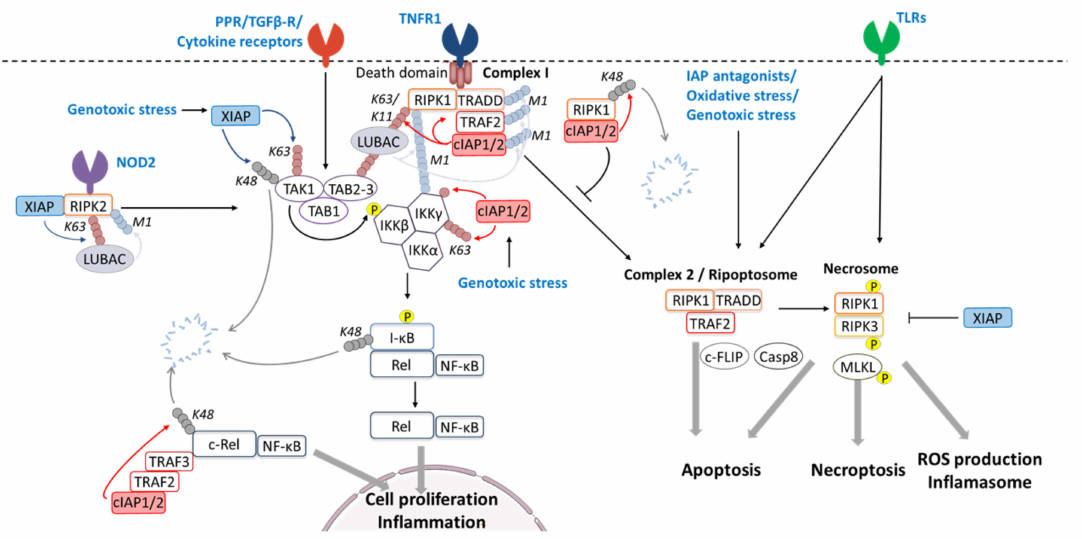
Figure 2. Regulation of the TNFR and canonical NF- κ B signaling pathways by IAPs. The activation of the tumor necrosis factor receptor 1 (TNFR1) induces the formation of the complex 1 composed of TNFR-associated death domain (TRADD), receptor-interacting kinase 1 (RIPK1), TNFR-associated factor 2 (TRAF2), and cellular inhibitors of apoptosis (cIAP1 / 2). The latter promote the ubiquitination of RIPK1 (K63 and K11-linked), leading to the recruitment of the linear ubiquitin chain assembly complex (LUBAC). In turn, LUBAC induces the conjugation of linear M1-linked polyubiquitin chains to complex 1 components. The resulting ubiquitin sca ff old allows the recruitment of TAK1 (tumor growth factor- β -activated kinase 1) / TAB1 / TAB2 / 3 (transforming growth factor-activated kinase1-binding protein 1, 2, and 3) complex and IKK (Inhibitor of κ B kinase) complex composed of IKK α / IKK β / IKK γ . TAK1 catalyses the phosphorylation of IKK β and the activation of IKK. This leads to the phosphorylation of the Inhibitor of κ B (I- κ B), its K48-linked ubiquitination, and proteasomal degradation, resulting in the release and nuclear translocation of NF- κ B subunits. Stimulation of PRRs (pattern-recognition receptors), TGF β -R (Transforming Growth Factor-beta receptor), cytokine receptors, NOD2 (nucleotide-binding oligomerization domain), or genotoxic stress can engage the canonical NF- κ B pathways by stimulating TAK1 / TAB1 / TAB 2 / 3 complex. XIAP (X-linked inhibitor of apoptosis protein) can positively regulate TAK1 activation through K63-linked ubiquitination or negatively through K48-linked ubiquitination and proteasomal degradation. In the case of NOD2 stimulation, XIAP promotes the K63-linked ubiquitination of RIPK2 that results in the recruitment of LUBAC and TAK1 activation. cIAPs can control IKK γ by promoting mono- or K63-linked ubiquitination, while the cIAPs / TRAFs E3-ubiquitin ligase complex can regulate c-Rel stability. A complex 2 derived from TNFR1-associated complex 1 or Ripoptosome that contain RIPK1 and RIPK3 can be formed in response to depletion of cIAPs by IAP antagonists, oxidative or genotoxic stresses, or TLRs (toll-like receptors) stimulation. Theses complexes can lead to apoptosis, necroptosis, or ROS production and inflammasome activation, depending on presence of the regulatory or e ff ector proteins c-FLIP (cellular FLICE-like inhibitory protein), caspase 8 (Casp8), and / or MLKL. cIAPs block complex 2 / ripoptosme assembly by inhibiting RIPK1 kinase activity and / or by mediating its K48-linked ubiquitination and degradation. Necrosome is negatively controlled by